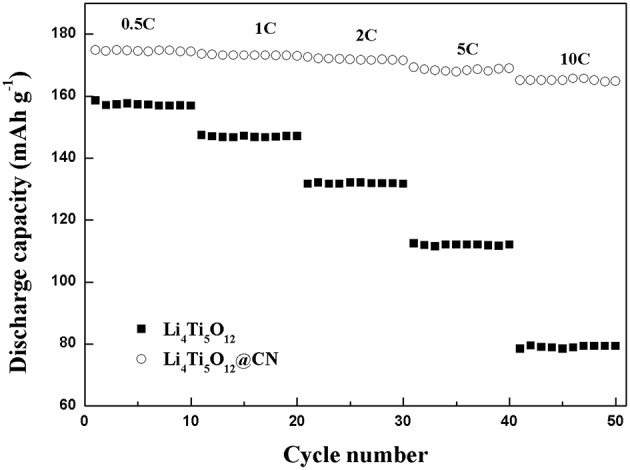
Rate property of Li4Ti5O12 and Li4Ti5O12@CN composite at different rates from 0.5 C to10 C.